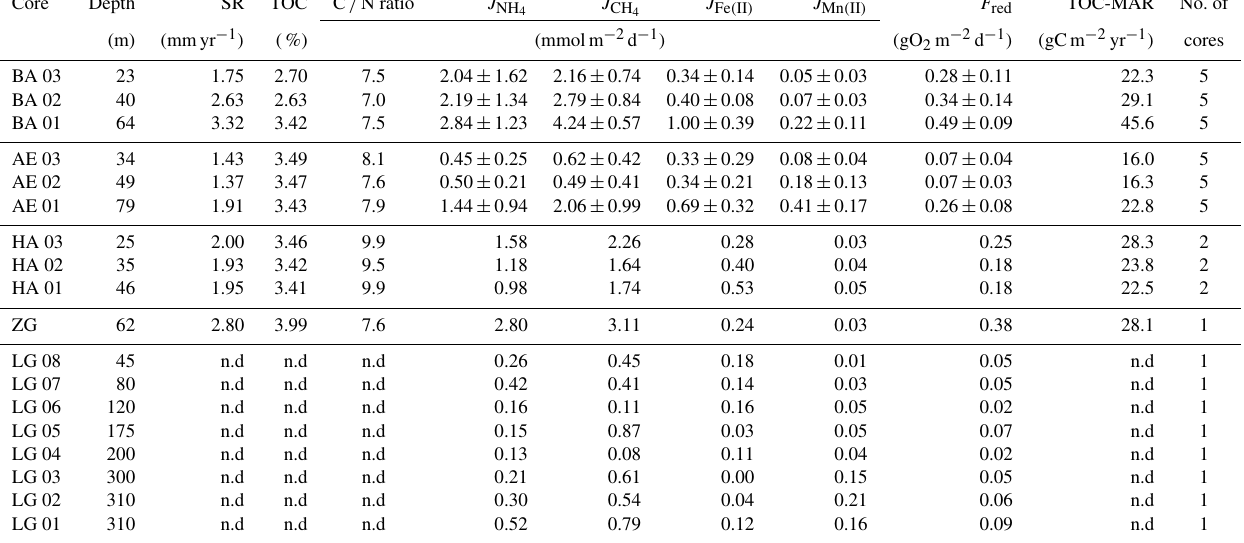
Table 2. Results from sediment and porewater analyses. Porewater fluxes are averaged over all flux measurements of each individual species. Standard deviations ( ± ) are based on all measurements. TOC was averaged from 2 to 10cm sediment depth. TOC and net sedimentation